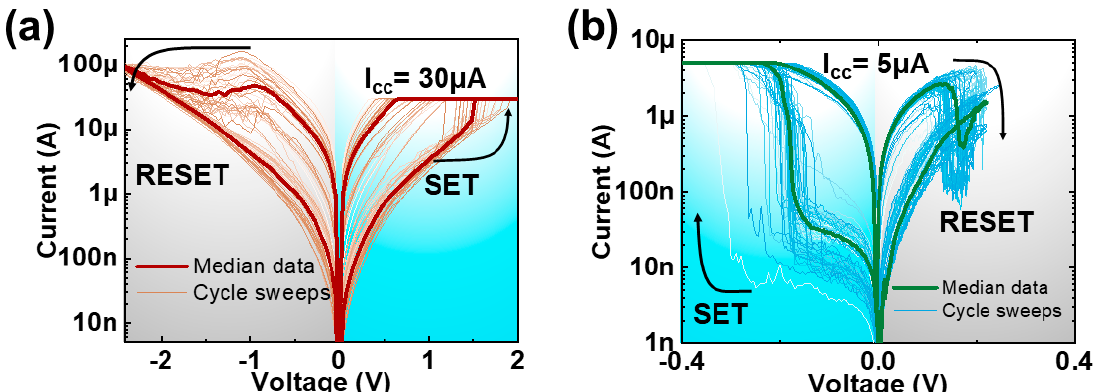
Figure 2. I-V response of the ( a ) Pt- and ( b ) graphene-based VRRAMs with multiple DC cycles. Blue and gray regions represent SET and RESET operations in each device, respectively.